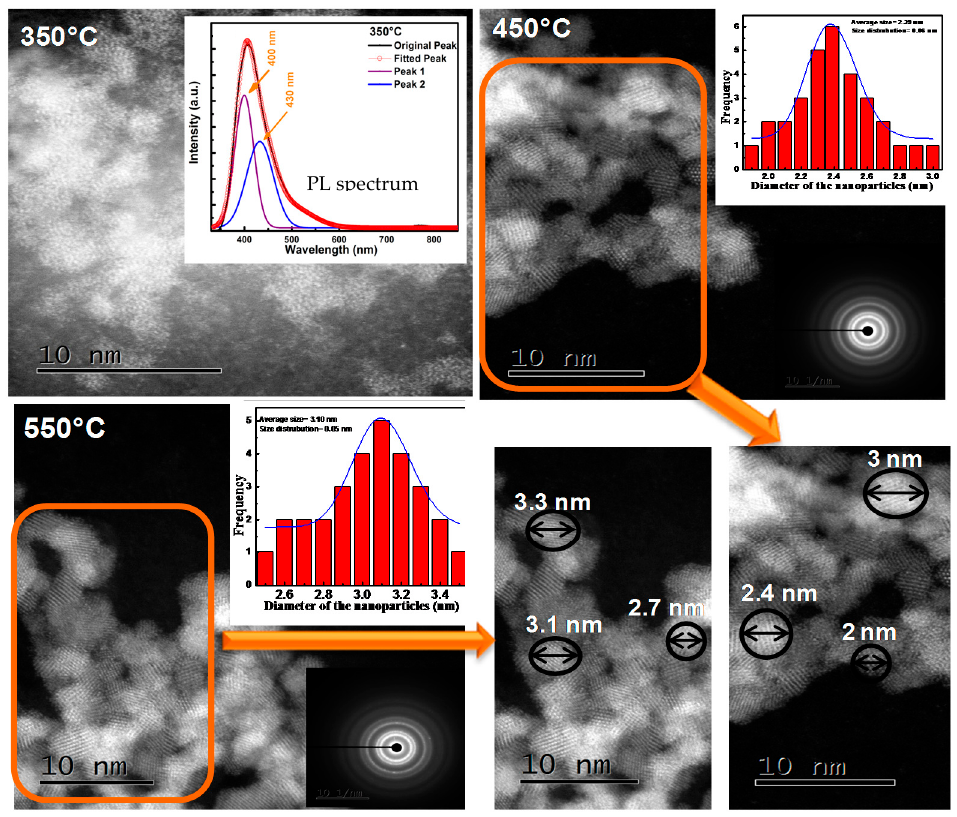
Figure 12. HRTEM images of SnO 2 QDs with SAED patterns at different combustion temperatures with the 350 °C PL spectrum as an inset [55].